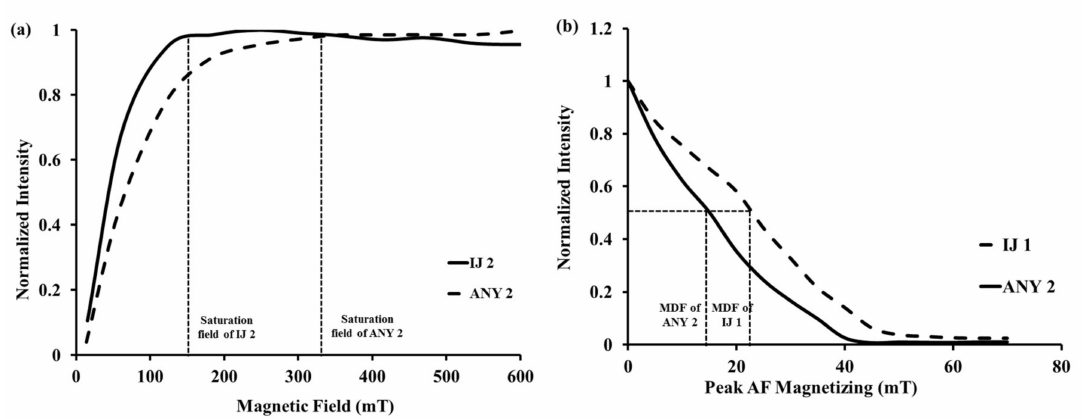
Figure 4. ( a ) Isothermal remnant magnetization (IRM) saturation curve and ( b ) anhysteretic remnant magnetization (ARM) decay curve of some samples. SD: Single Domain, PSD: Pseudo Single Domain, MD: Multi Domain, SP: Superparamagnetic, and MDF: Median Destructive